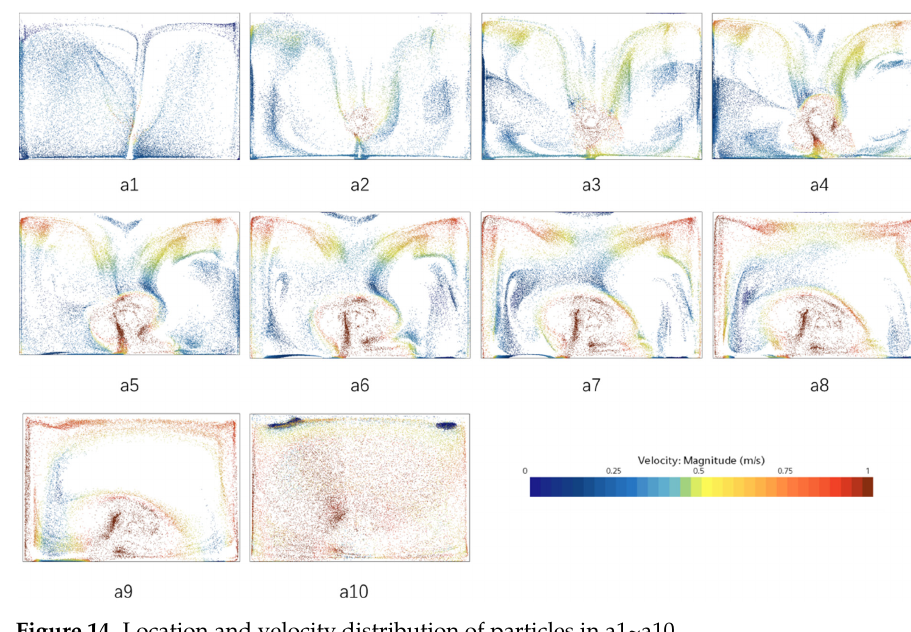
Figure 14. Location and velocity distribution of particles in a1~a10.